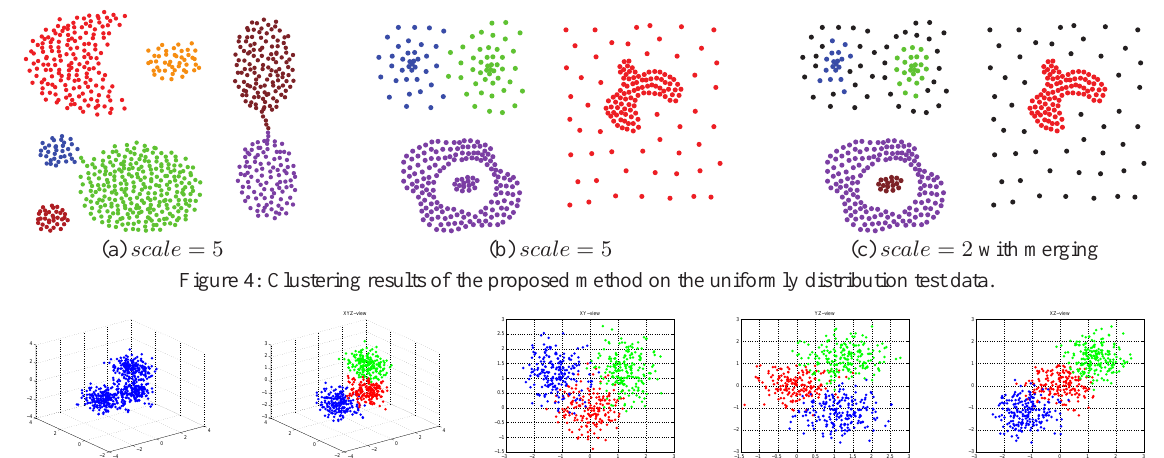
Figure 5: Clustering results of the proposed method on the 3D ( XY Z ) simulated test data: the original data points and the clustering result projected onto the XY plane, the Y Z plane, and the XZ plane from left to right. these tests, only the parameter θ was adjusted to get the best seg- mentation results without any filtering or